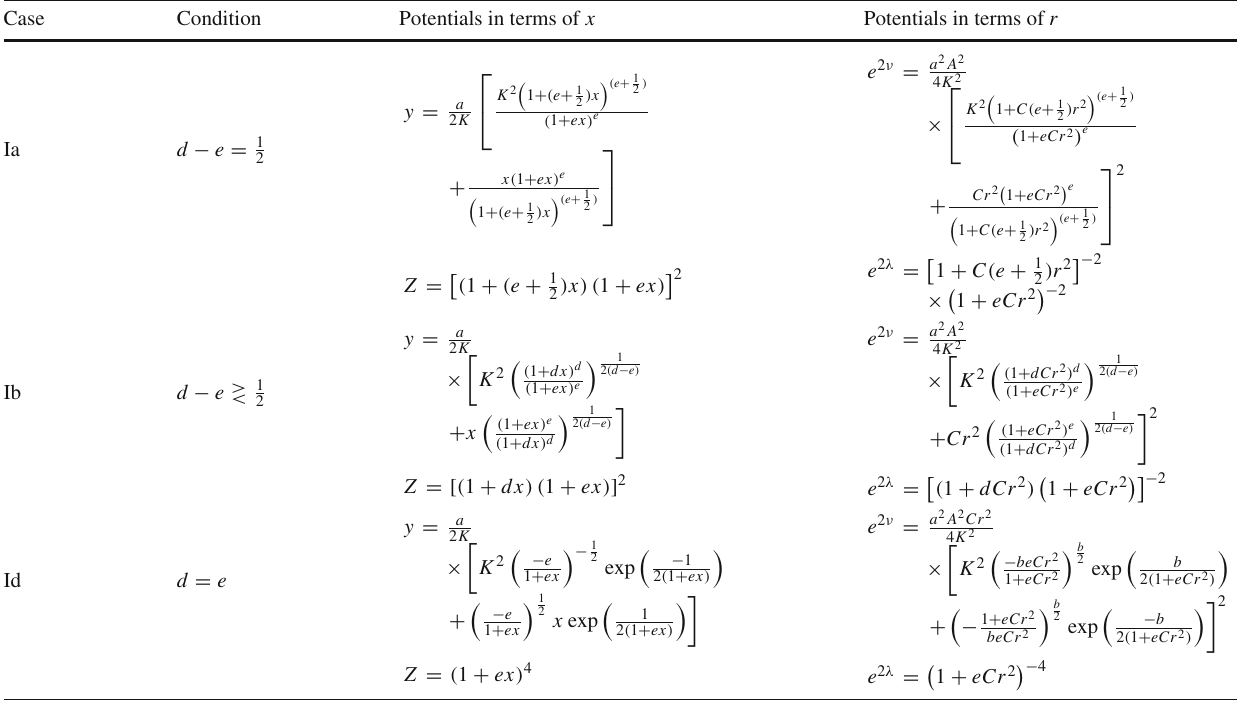
Table 1 Potentials for Class I